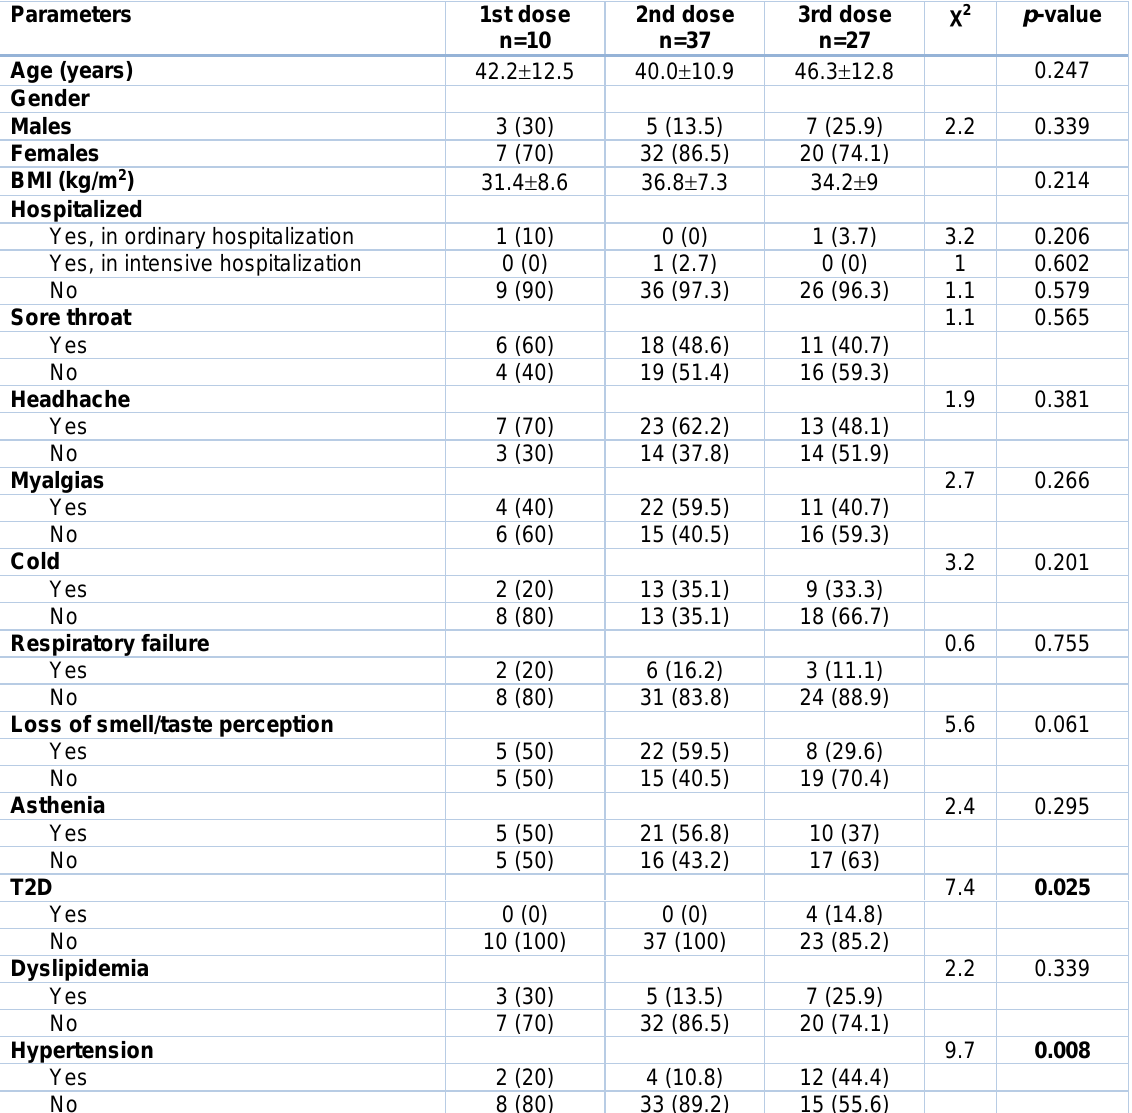
Table 1: Anthropometric parameters, clinical manifestations, and medical illnesses of COVID-19 vac- cine breakthrough according to the completed doses of vaccine